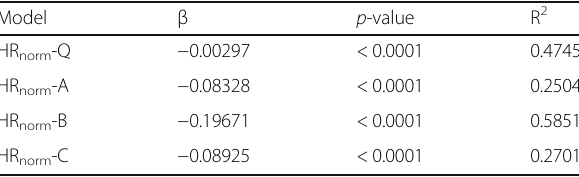
Table 1 Regression coefficients and goodness of fit values for potential predictors of heart rate